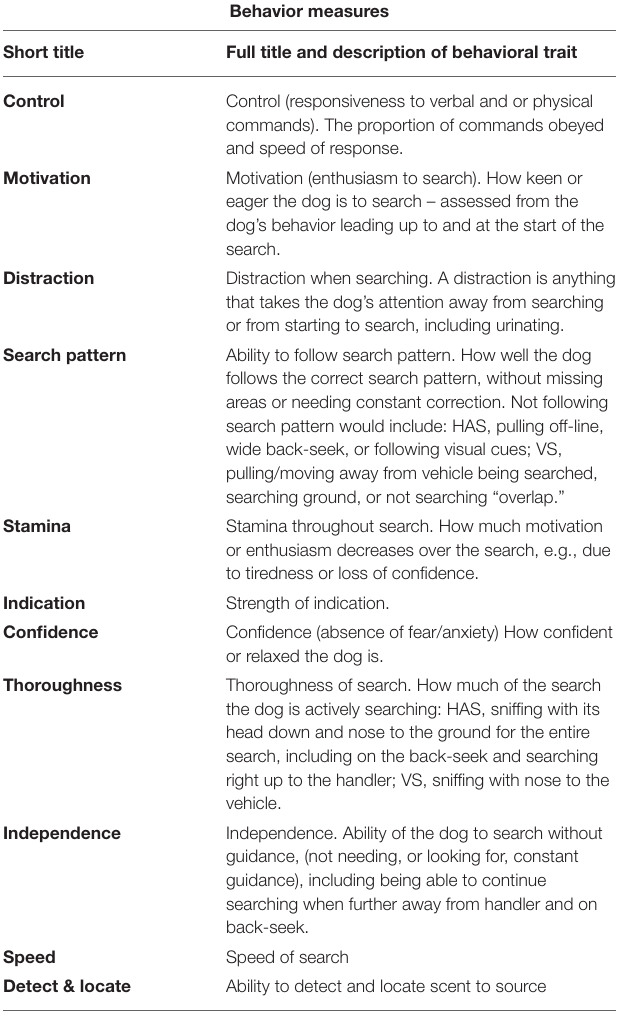
TABLE 1 | Behavioral measures of performance (traits) in the order they were